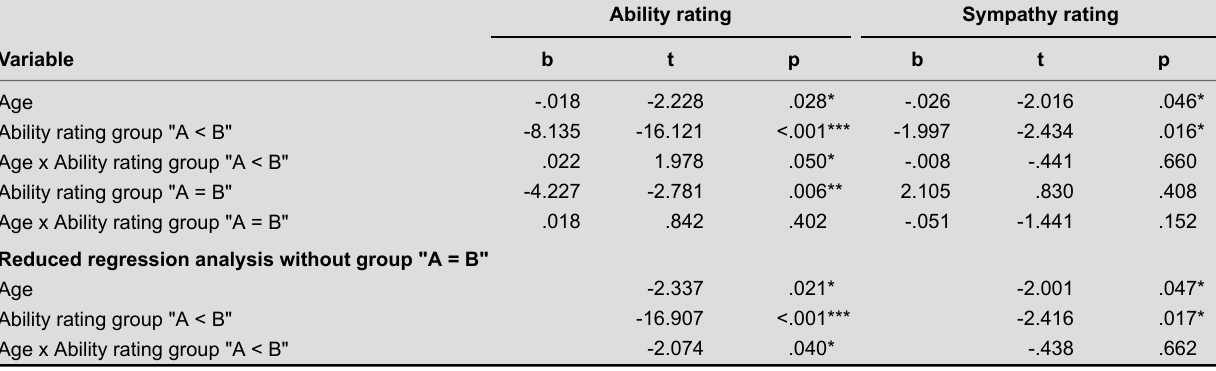
Result of the Multiple Regression Analysis